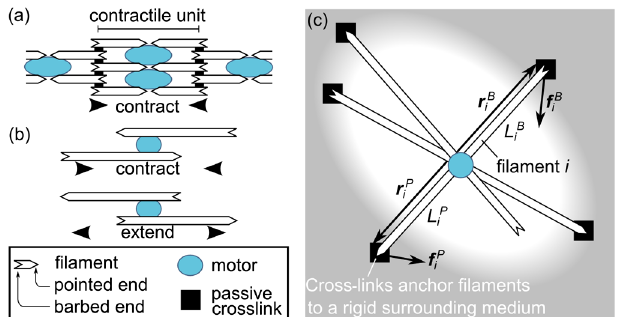
FIG. 1. Geometrical foundations of contractility. Motors bound to filaments slide toward their “ barbed ends, ” as for myosin II thick filaments. (a) In striated muscle, motors are localized close to the filaments ’ pointed ends. When activated, every motor pulls in the neighboring filaments and thus induces local contraction. (b) If filament polarities are not carefully selected, striated muscle-like locally contractile configurations (top) are just as likely as extensile ones (bottom), and the overall behavior of the actomyosin assembly is unclear. (c) The symmetry between contraction and extension subsists in a two- or three-dimensional network. Throughout this article, filament extremities may or may not be cross-linked to the surrounding medium. Even though this is not represented here, cross-linked filaments extend beyond the cross-links and farther into this medium, and thus cannot freely rotate around these cross-links. Thus, the barbed and pointed arrow ends on this schematic merely indicate filament polarity; the actual barbed and pointed ends of cross-linked filaments are typically farther away, inside the surrounding